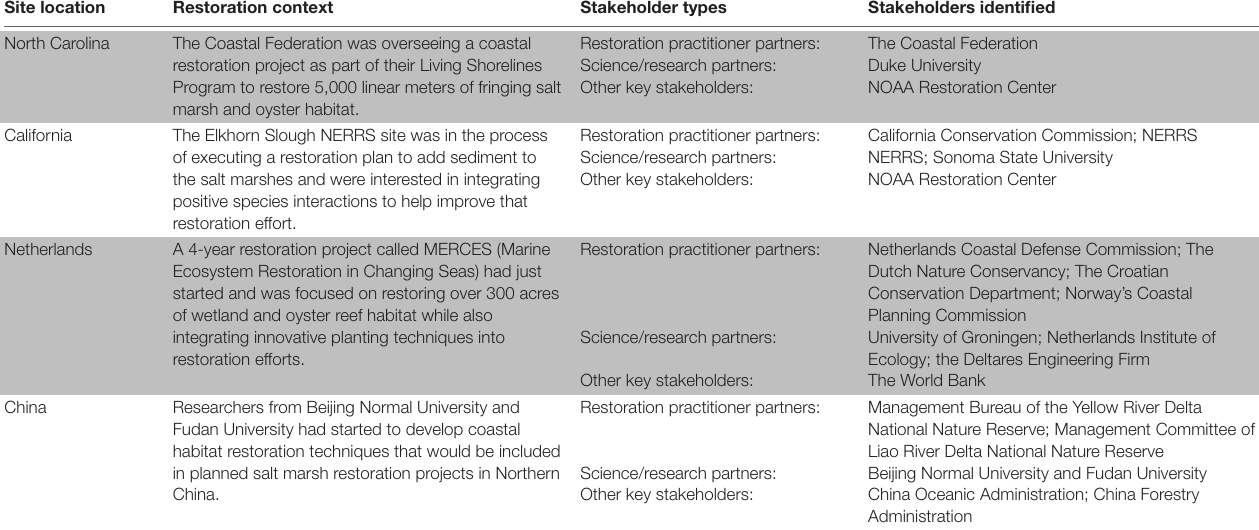
TABLE 2 | Site locations, restoration context, and partners identified through project scoping and development for integrating positive species interactions at four coastal restoration